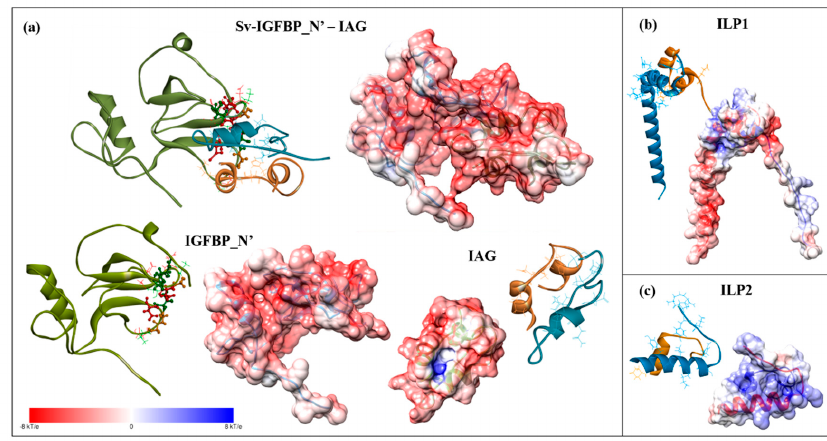
Figure 7. Electrostatic potential surface of: ( a ) Sv-IGFBP_N’-IAG complex and the individual binding partners; ( b ) ILP1; and ( c ) ILP2. IGFBP_N’ is coloured in green and the ligands in blue and orange; the interacting hotspot residues of IGFBP_N’ are highlighted as described in Figure 6c; ligands have been orientated to display the binding interface. Surfaces are colored by potential on the solvent accessible surface on a scale of − kT/e (red) to +kT/e (blue), as indicated by the scale bar.